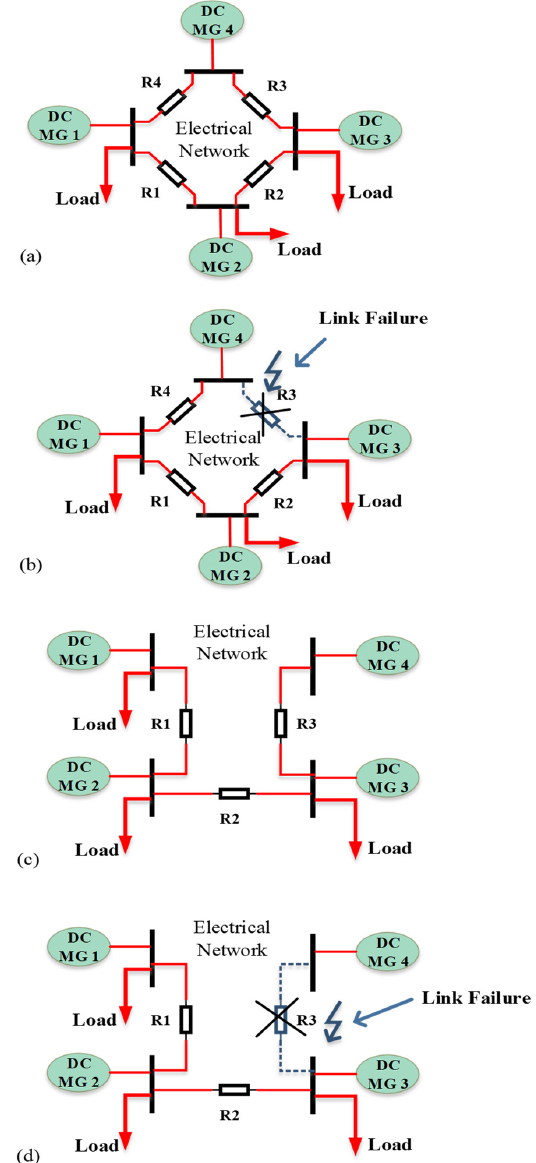
Figure 5. Electrical Network Scenario ( a ) Ring Type Network, ( b ) Ring Type Network with Fault, ( c ) Radial Type Network, ( d ) Radial Type Network with Fault.